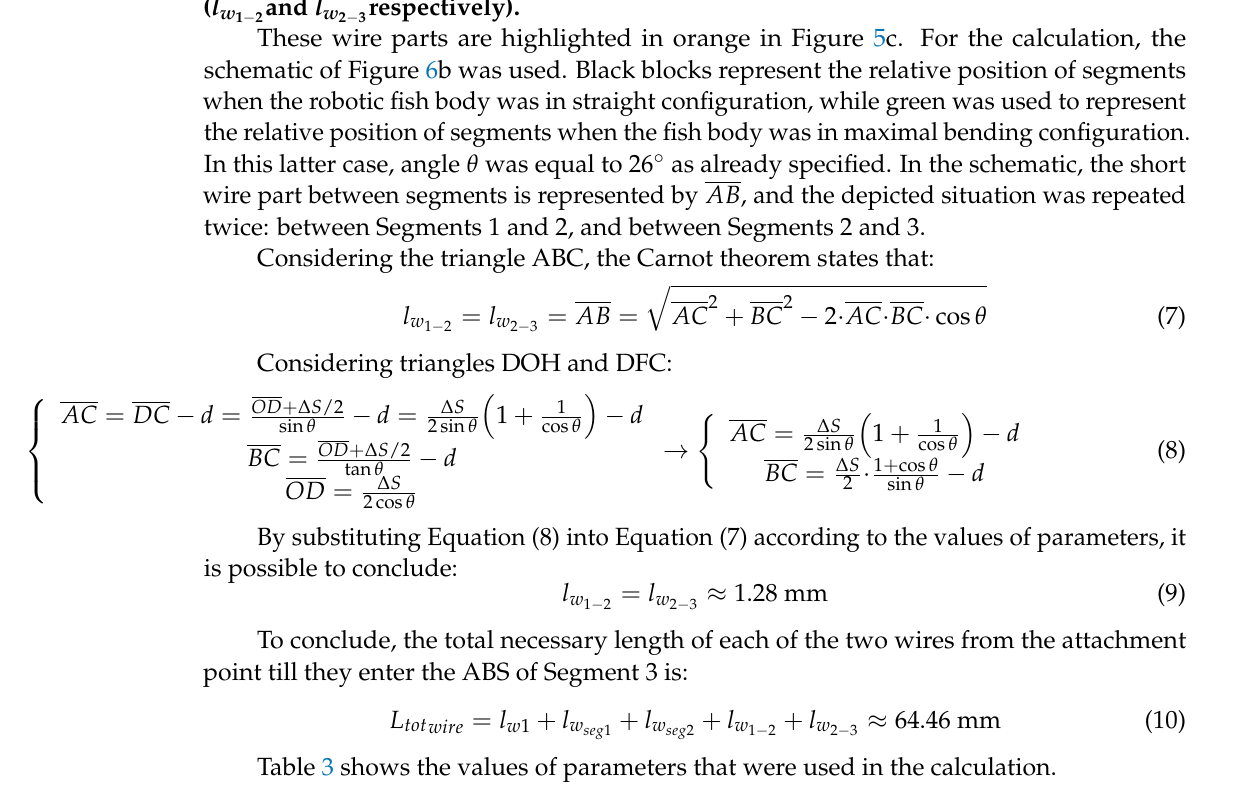
Table 3. Values of the parameters used in the wire-driven